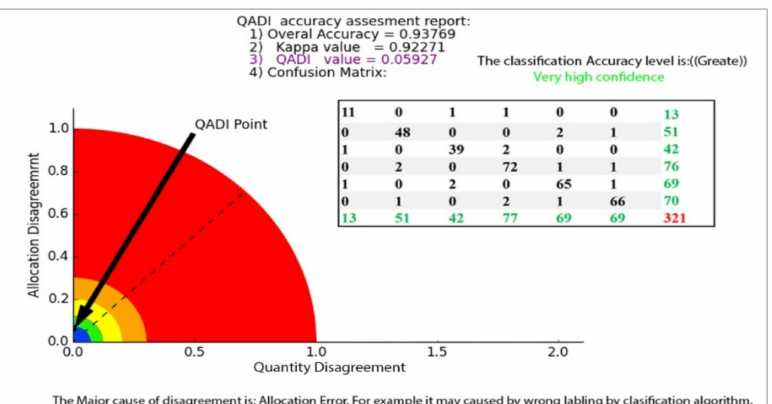
Figure 7. The QADI graph for the error matrix of the OBIA-based LULC classification (Table 6) by Naboureh et al.